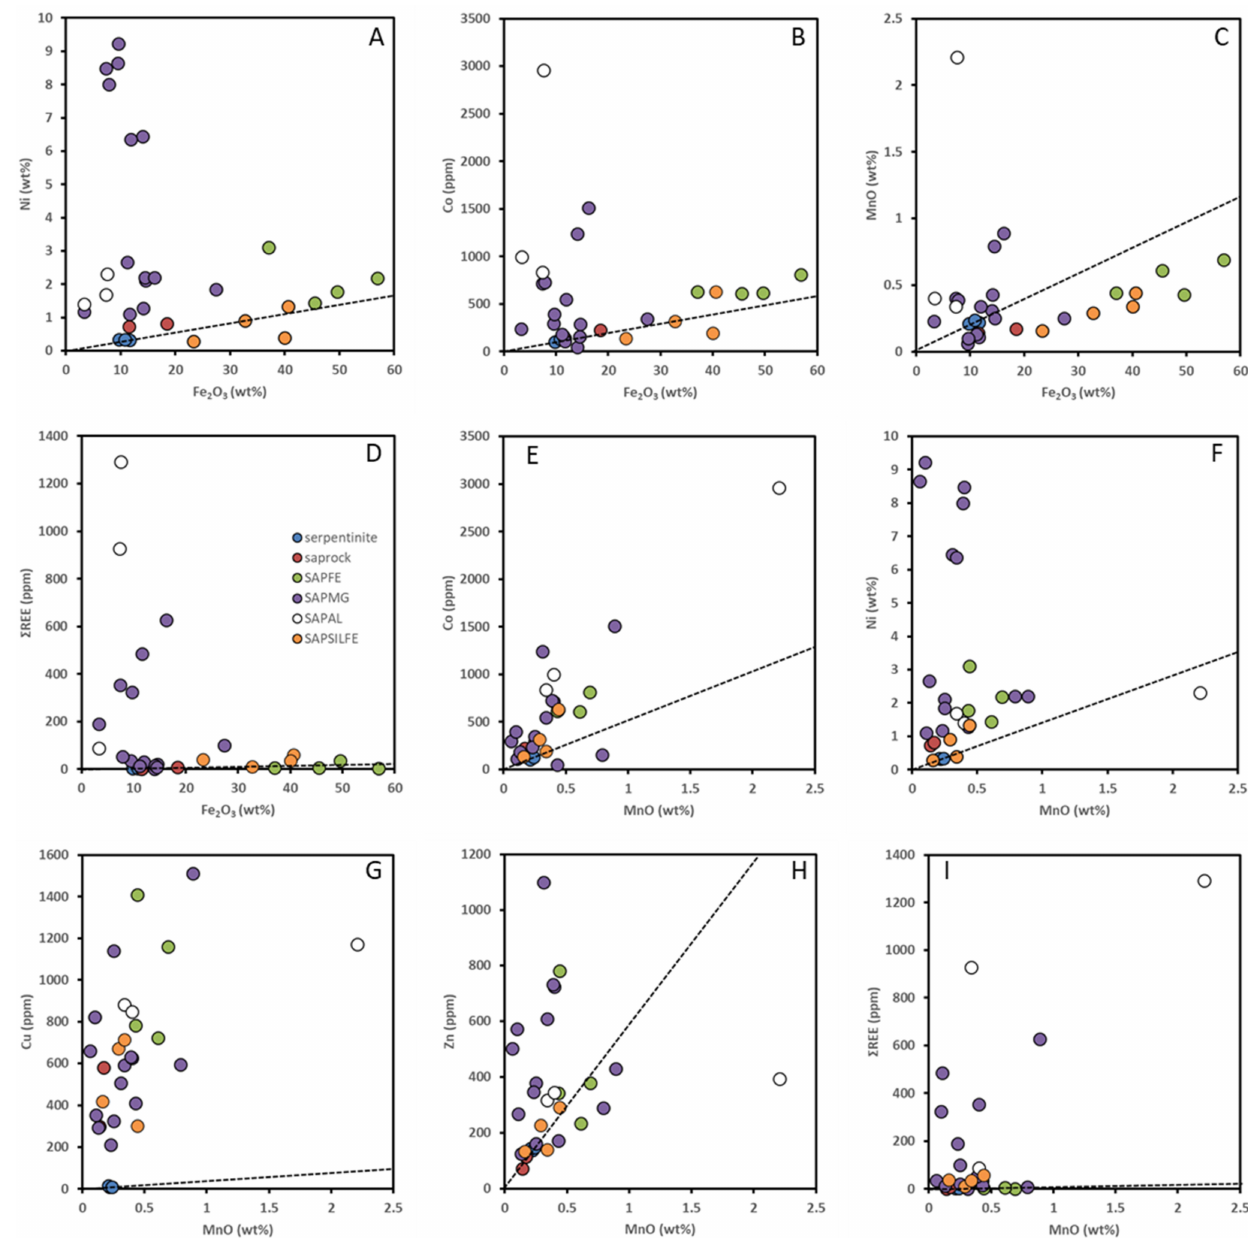
Figure 5. ( A – D ) Concentrations of Ni, Co, MnO and Σ REE plotted against wt% Fe 2 O 3 . ( E – I ) Con- centrations of Co, Ni, Cu, Zn and Σ REE as a function of wt% MnO. The dotted lines represent the equal residual enrichment trends e.g., [15] qualitatively showing relative enrichment with respect to the